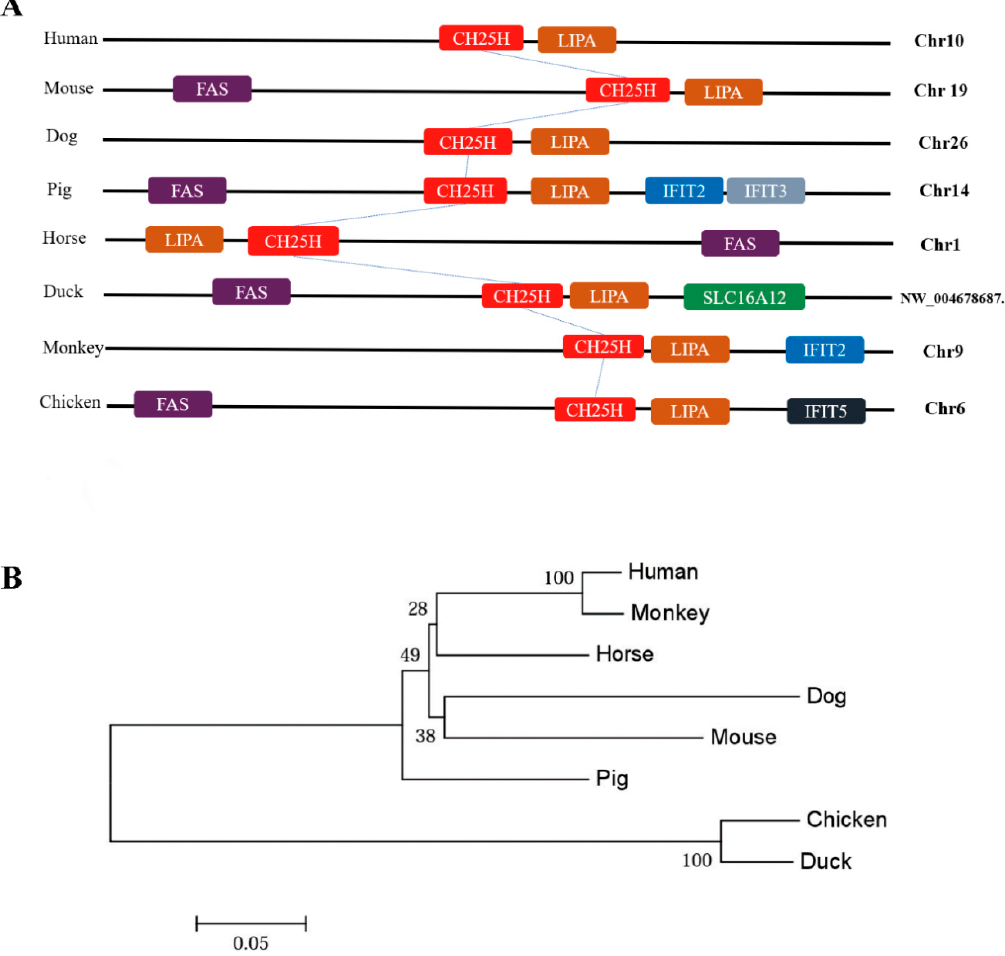
Figure 3. Chromosomal location and phylogenetic analysis of chCH25H. ( A ) Genomic architecture of CH25H genes in human, mouse, dog, pig, horse, monkey, duck and chicken. All of the CH25H locus in compared species is flanked with LIPA gene. chCH25H located on chicken chromosome 6. ( B ) Phylogenetic analysis of CH25H genes in different species. The chicken and duck CH25H genes clustered together in a group distinct from those of mammals.